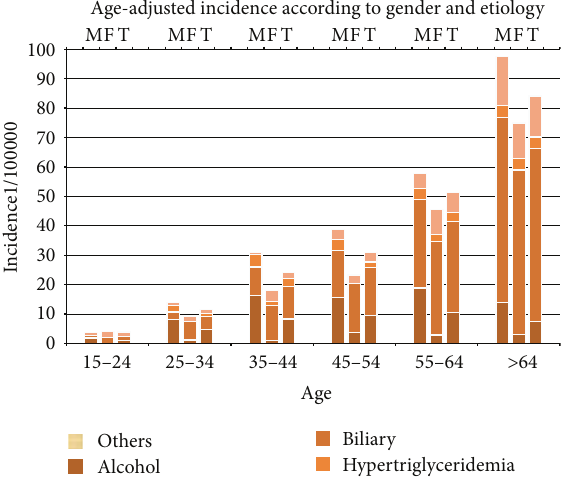
Figure 2: The incidence and etiology of acute pancreatitis change with aging. (M: male; F: female; T: